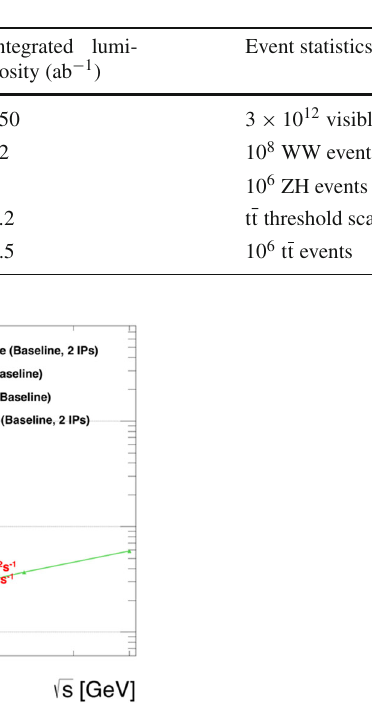
Fig. 2.2 Luminosity as a function of centre-of-mass for the FCC-ee with two interaction points. The simulated luminosity is shown, together with a slightly more conservative one. Also shown are those estimated for ILC, CLIC and CEPC, at the time of submission